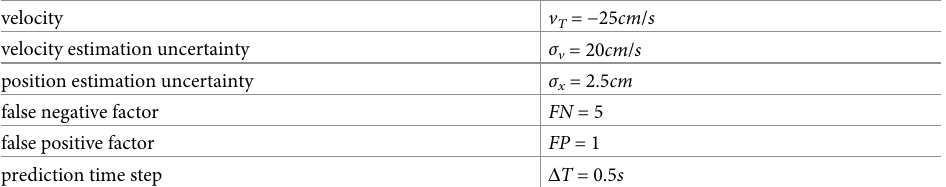
Table 1. Baseline model parameters. Negative values for velocity v T indicate objects approaching the body, while posi- tive values would indicate objects receding from the body. In simulations we manipulate each of these parameters, except for σ and FP . x